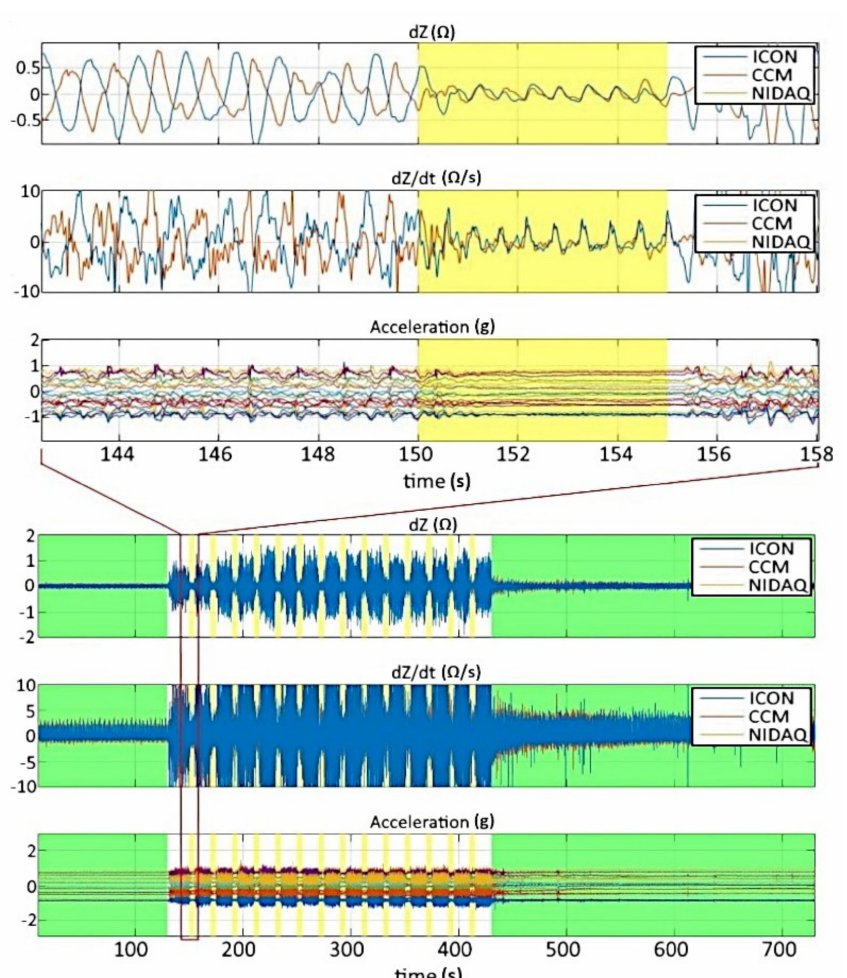
Figure 11. Raw data from the ergometry stress test after the acquisition—the lower part shows complete signal (dZ, dZ/dt, and acceleration), the upper part shows zoomed version—baseline and recovery phase are marked green, breaks during cycling are marked yellow (subject 6). Disturbances in both bioimpedance signals are inversely phased and diminish with a delay after the start of the